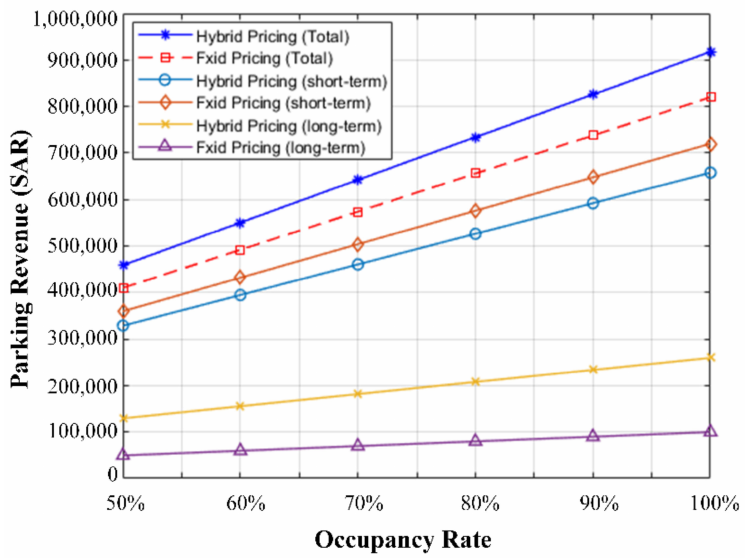
Figure 11. The revenue from the parking lot in one month with different occupation